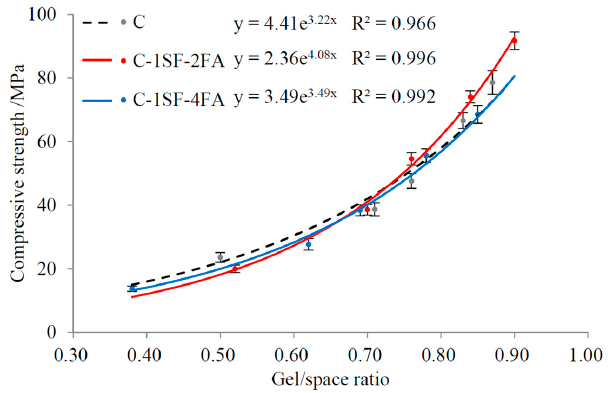
Figure 12. Relation between compressive strength and gel/space ratio.